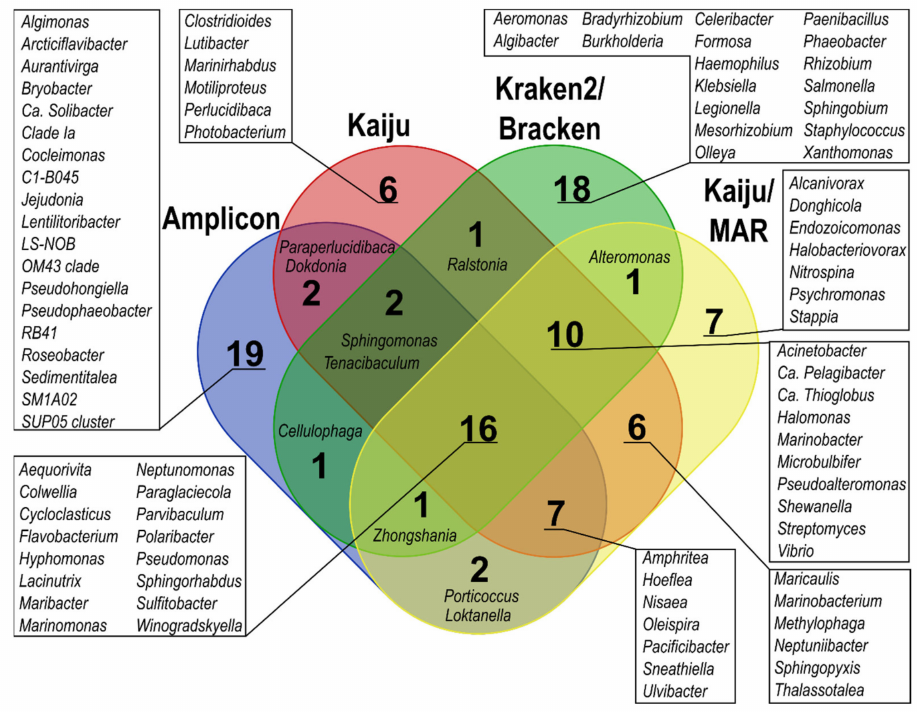
Figure 4. Venn diagram showing the overlap of the 50 predominant bacterial genera between different taxonomic classification